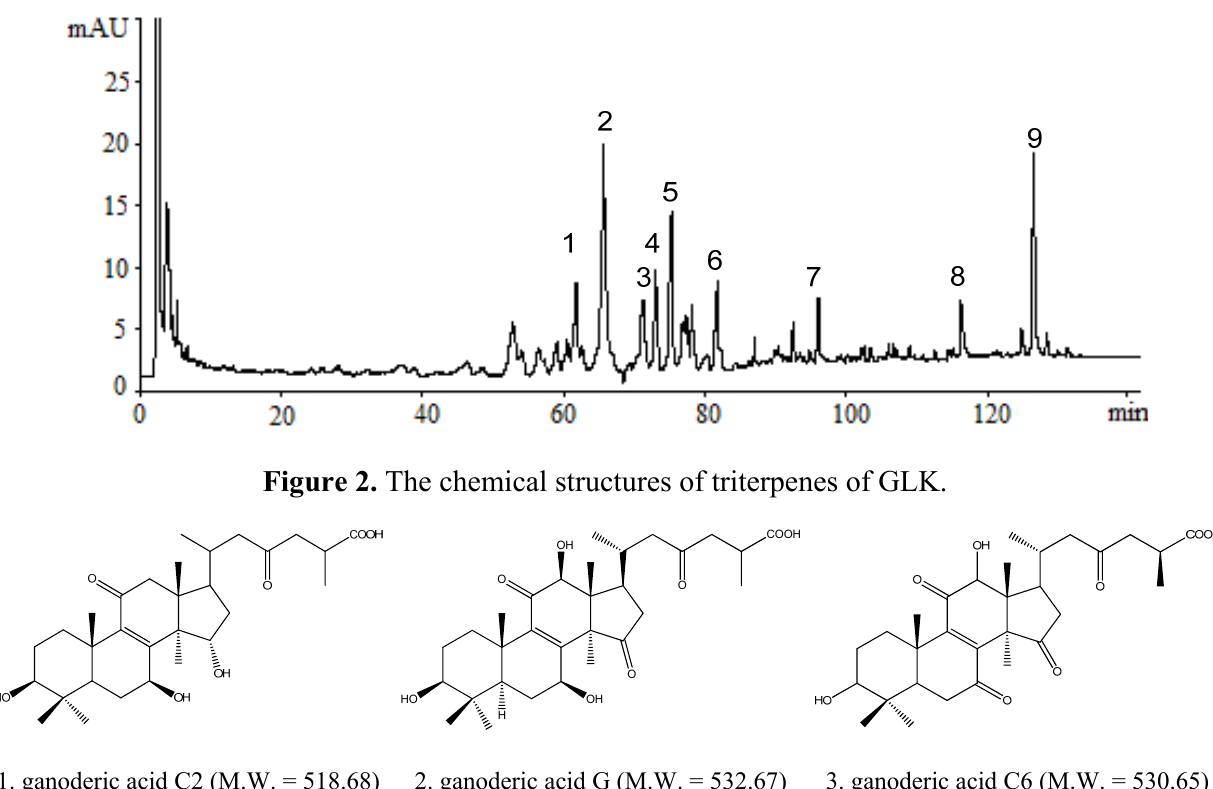
Figure 1. HPLC chromatograms of triterpenes in extract of GLK. (1) ganoderic acid C2;